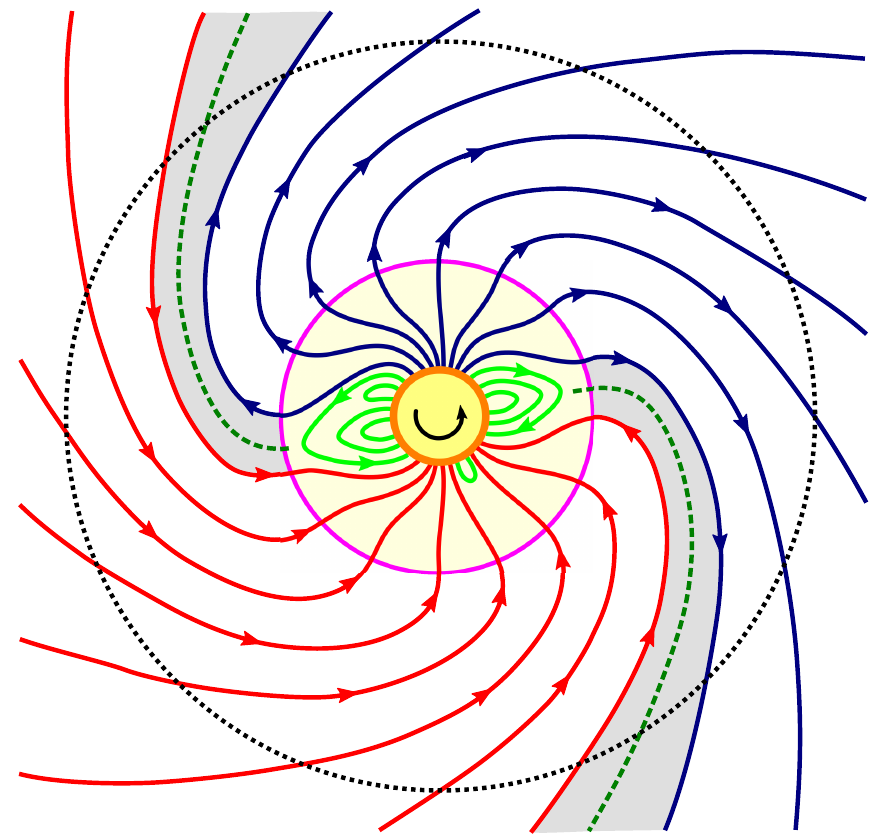
Figure 1. Schematic representation of the solar wind structure in the ecliptic plane. The Sun cor- responds to a small colored circle in the center. The arrow shows the direction of rotation of the Sun. The boundary of the middle circle indicates the region of the corona, at the edge of which the magnetic field becomes purely radial. The shaded gray areas correspond to the zones of the heliospheric current sheet (shown by dotted lines running from the corona to the periphery), which separates the solar wind magnetic field with different directions of magnetic field lines (from the Sun or to the Sun). The orbit of a hot exoplanet is shown by a dotted circle, which is located in the heliospheric